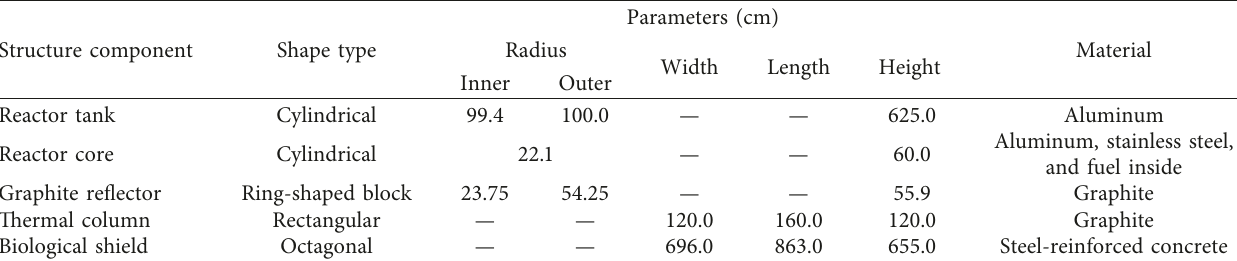
Table 1: Main parameters of the DNRR structure